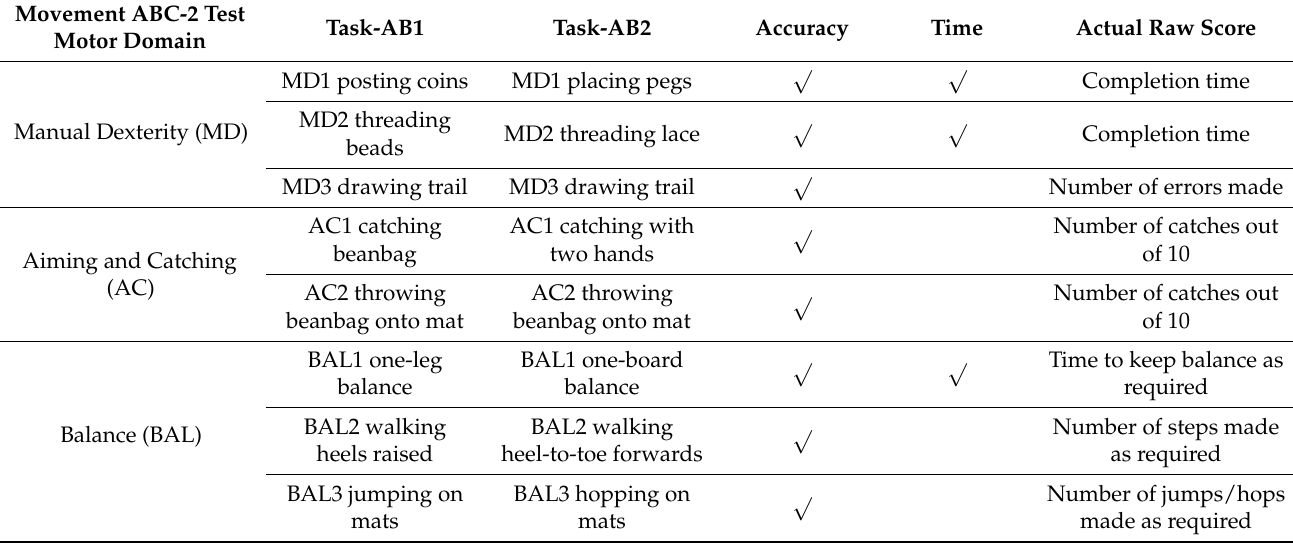
Table 2. Tasks and measurements in the Movement ABC-2